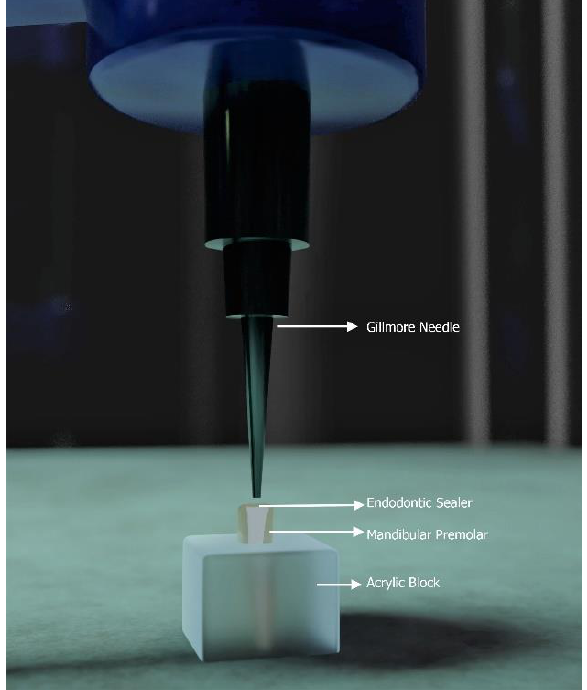
Figure 1. Schematic representation of the setting time analysis apparatus used for this study using a 100 g Gillmore needle set in an incubator.